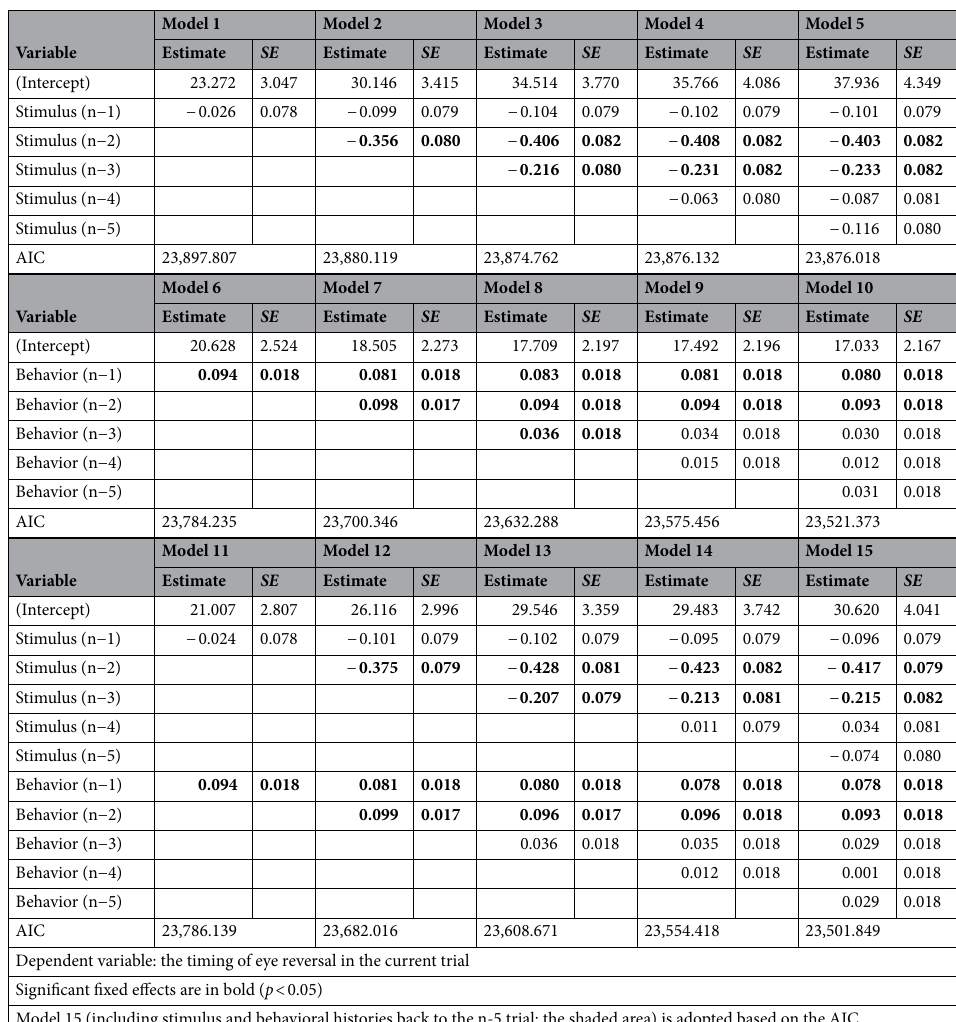
Table 1. Linear mixed-effects models with the timing of eye reversal in the current trial (n) in the unpredictable